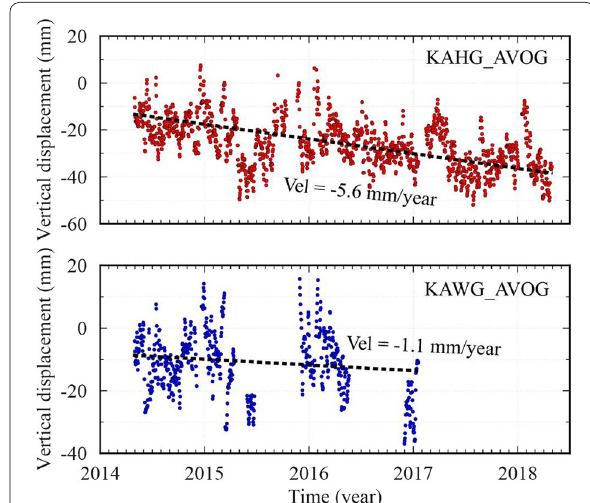
Fig. 10 Vertical displacement time series at two GNSS stations KAHG and KAWG with respect to the station AVOG between October 2014 and March 2018. The vertical displacement rate at each station is also